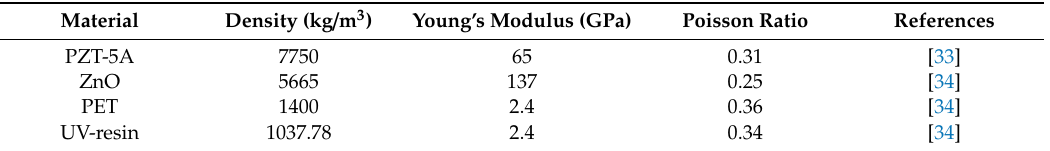
Table 2. Properties of the materials considered in both PEH devices. Reprint with permission from